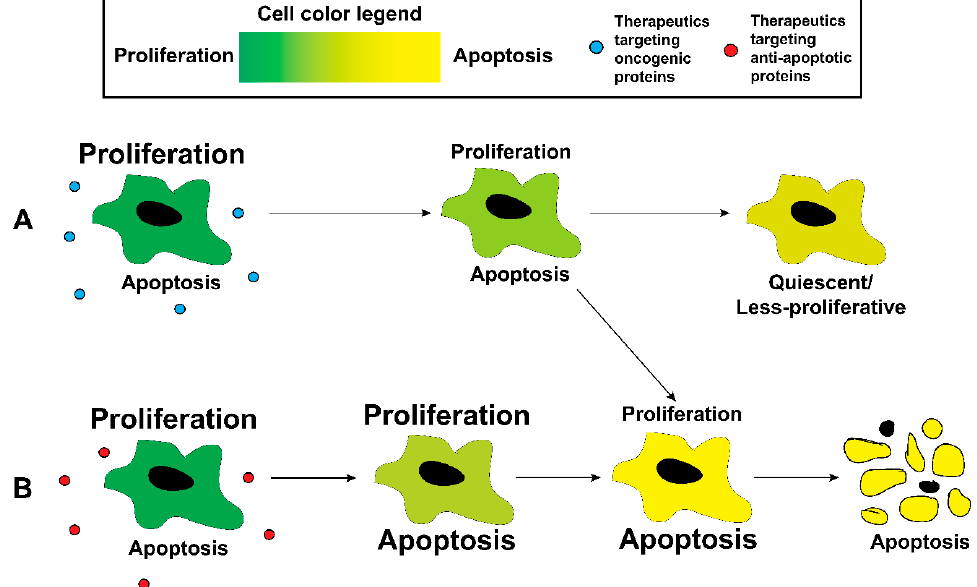
Figure 2. Treatment of proliferative cancer cells with either ( A ) therapeutics targeting oncogenic pathways or ( B ) therapeutics targeting antiapoptotic proteins can increase the probability of the cell undergoing apoptosis or undergoing quiescence.